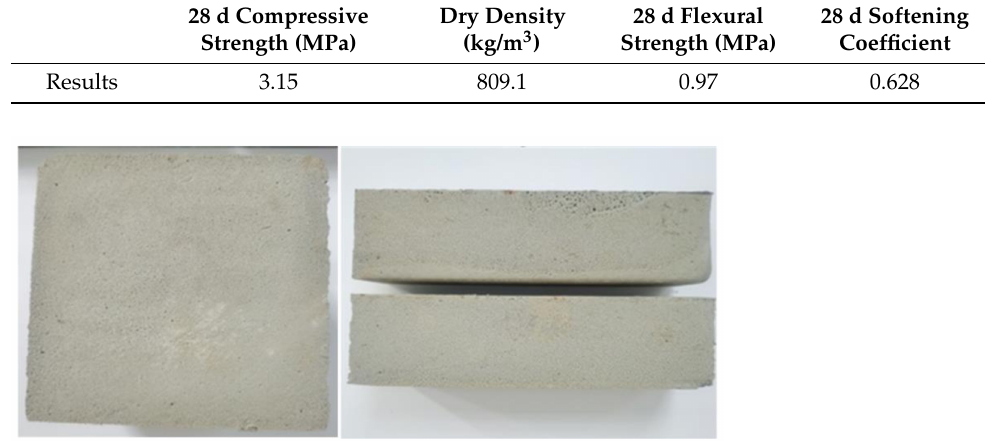
Figure 5. The surface of the A 3 B 3 C 2 B 4 specimen.